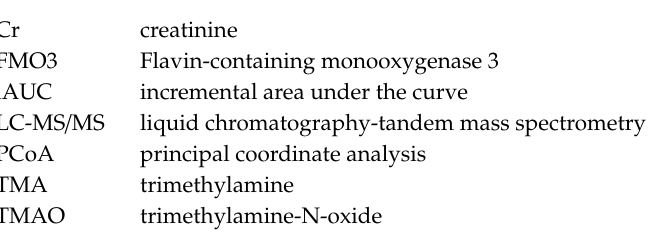
Table S1: Percentile abundances of taxa at genus level and W-statistics for high-TMAO producers ( n = 17; those with ≥ 40% urinary TMAO increase from 0 min study-baseline in response to choline bitartrate) versus low-TMAO producers ( n = 17; those with < 40% urinary TMAO increase from 0 min study-baseline in response to choline